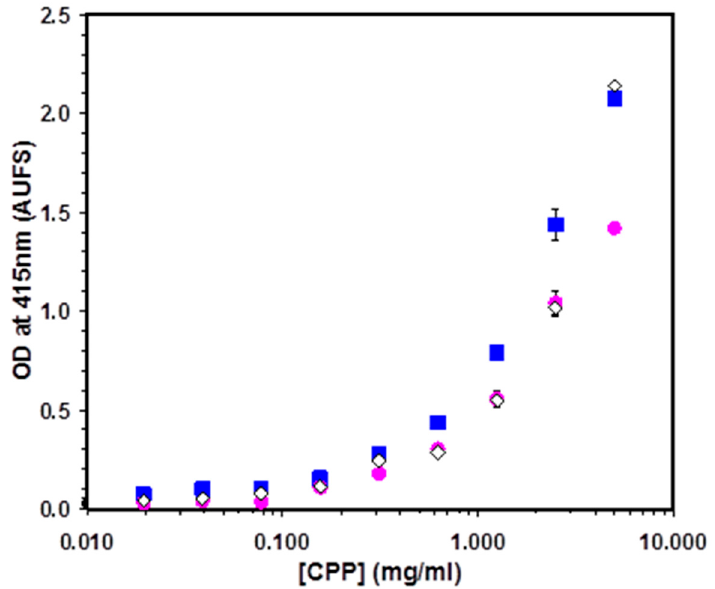
Figure 4. ELISA of α S1 -CN (59–79) binding to whole saliva (blue squares) and parotid saliva (red circles) and β -CN (1–25) binding to whole saliva (white diamonds).